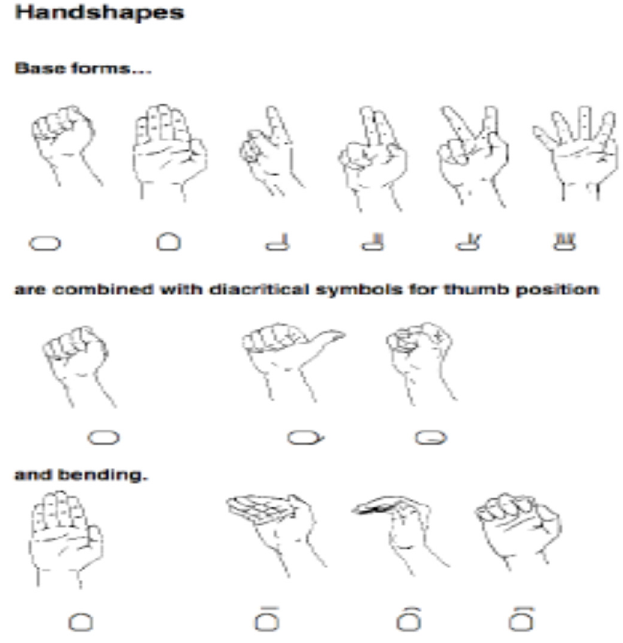
Figure 1. Various Handshapes in HamNoSys. Indian Sign Language consists of gestures as shown in Table 1.